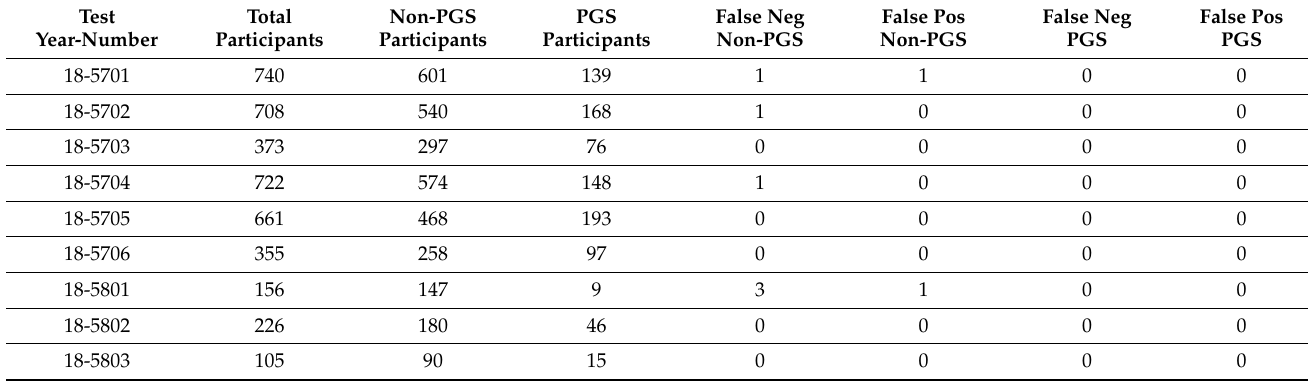
Table 1. An analysis of the CTS forensic biology summary reports for the years 2018–2021 showing the false positive and false negative results for PGS and non-PGS laboratories. Note that the Draft NIST Foundation Review showed only the numbers of false negative and false positive results with no attempt to distinguish PGS/non-PGS